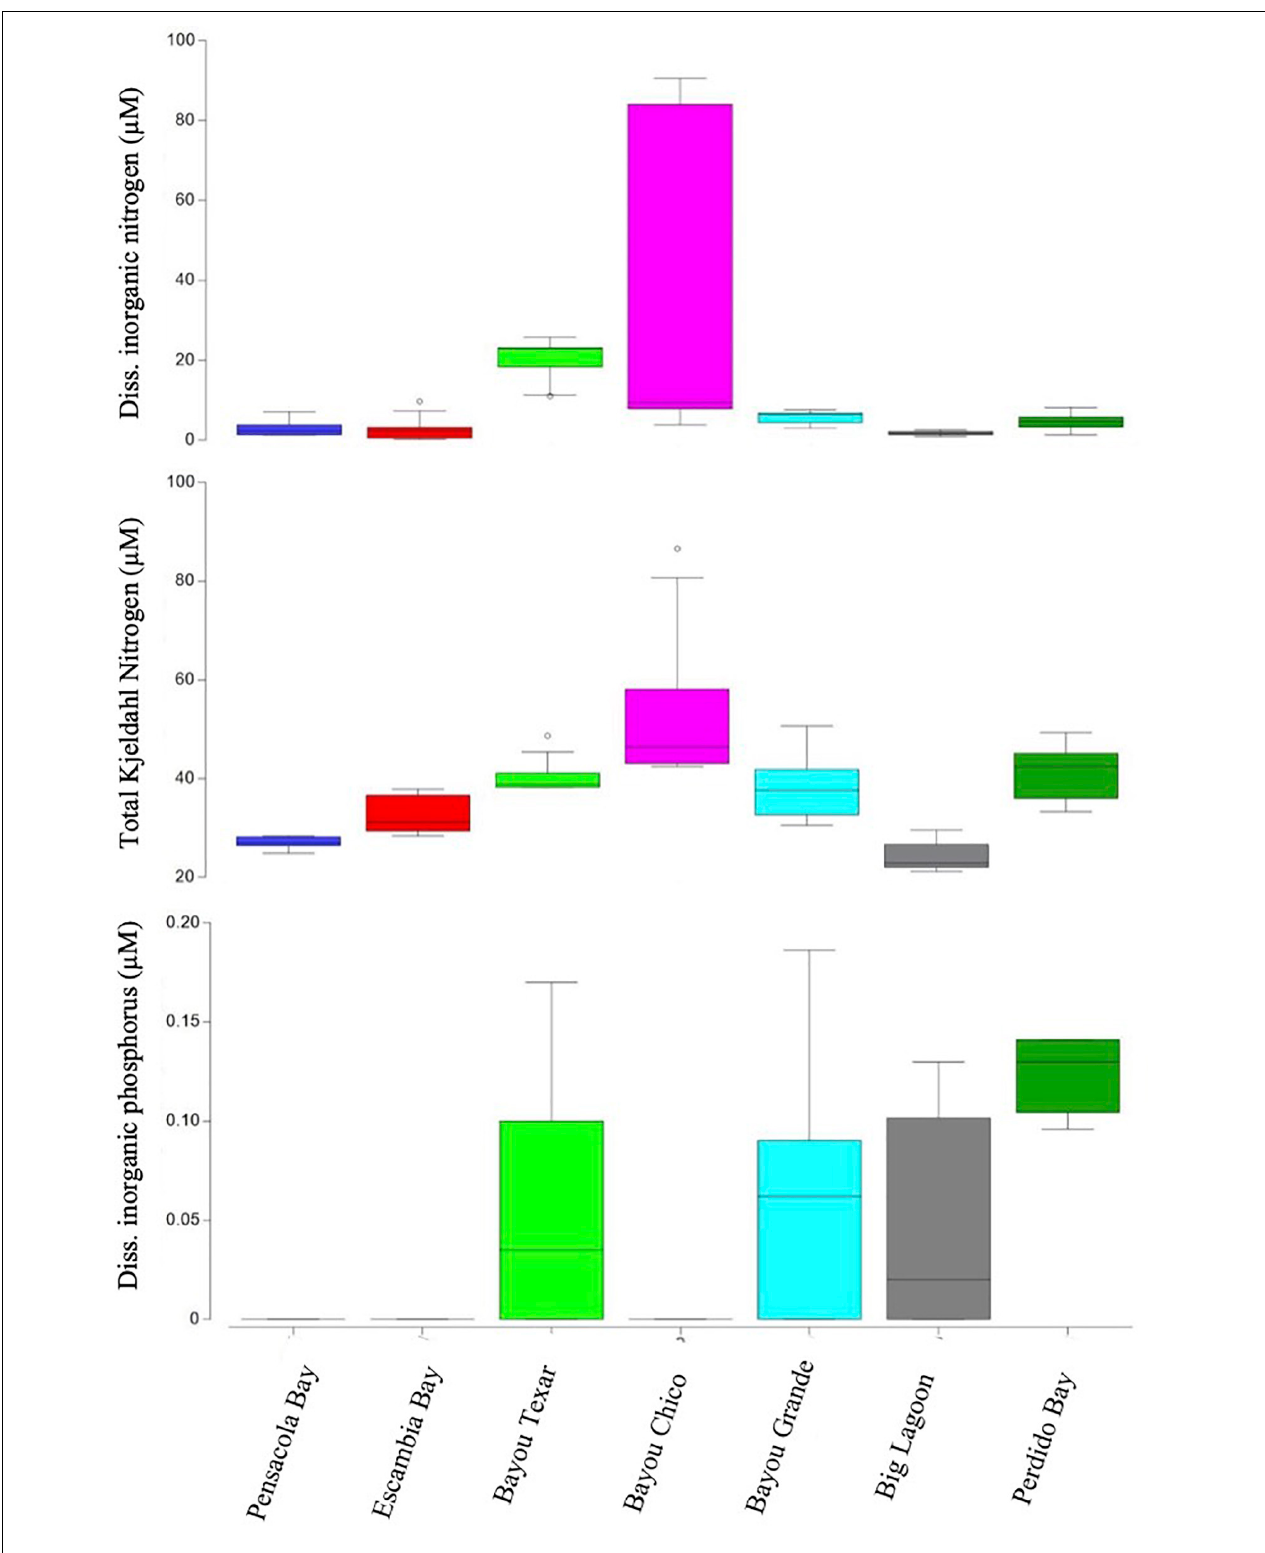
FIGURE 2 | Boxplots of dissolved inorganic nitrogen and phosphorous (DIN, DIP) and total Kjeldahl nitrogen (TKN) concentrations. Open circles denote extreme values; box-tops and -bottoms show the 25th and 75th percentiles; lines within boxes mark mean values; and whiskers indicate minimums and maximums.